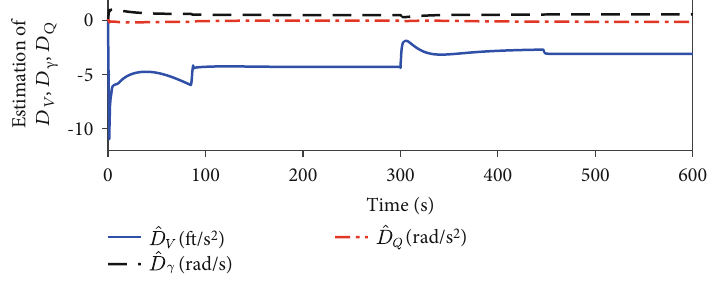
Figure 8: Results of lumped disturbance estimation.